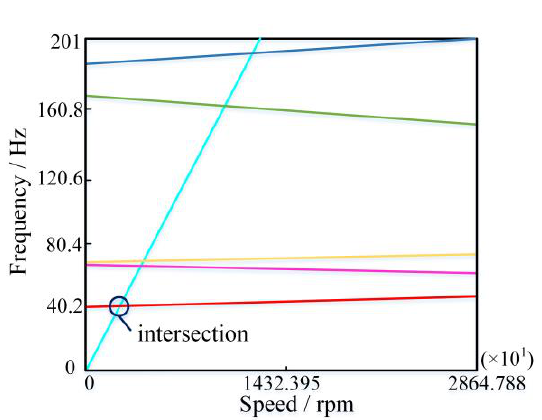
Figure 4. Description of the Campbell diagram.